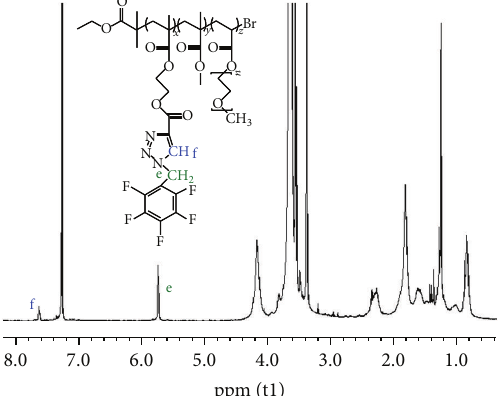
Figure 11: The 1 H-NMR spectra of the click product ( 4